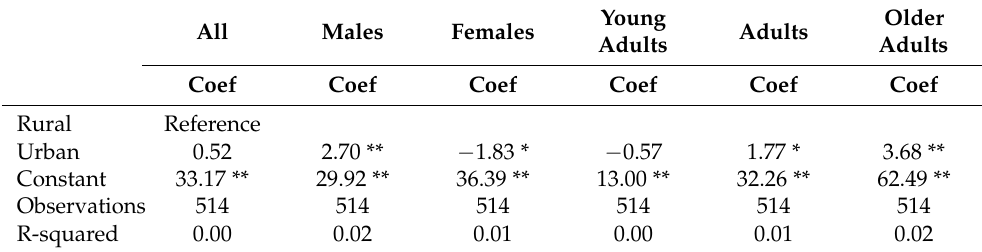
Table A1. Regression outputs for urban/rural differences.